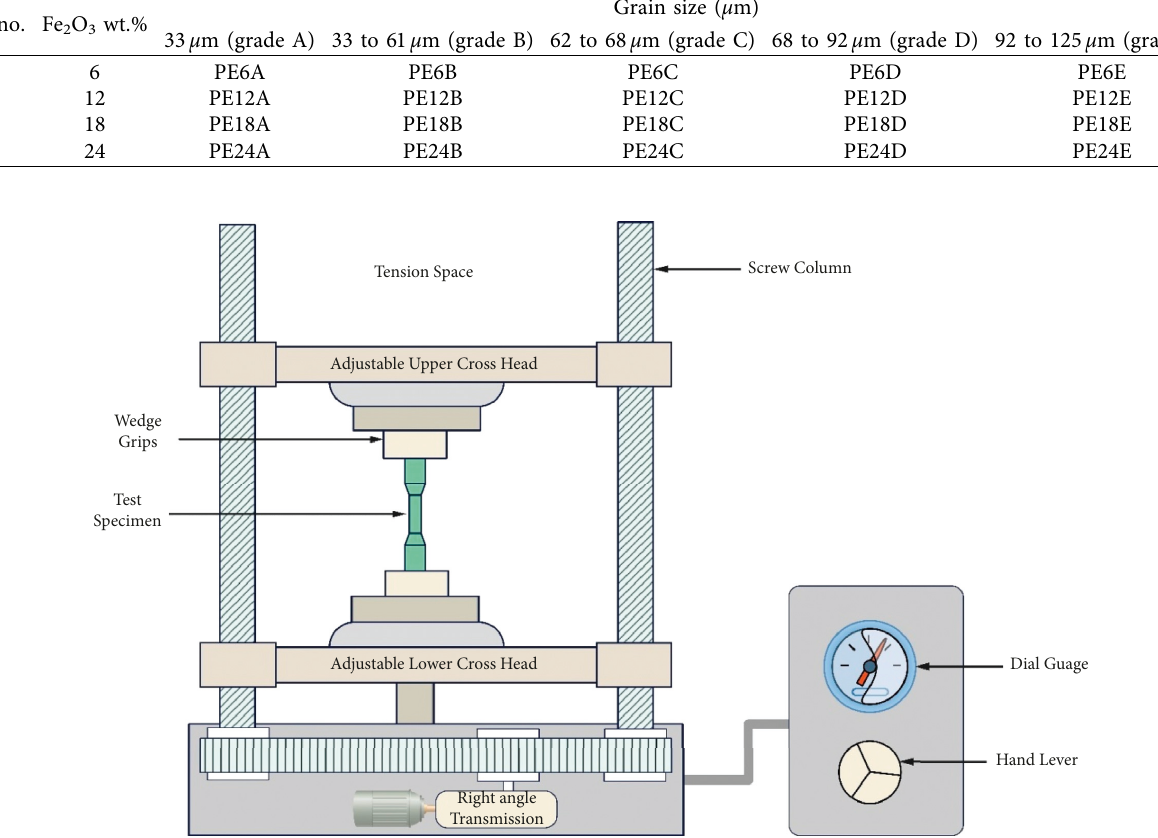
Figure 1: Universal testing machine.